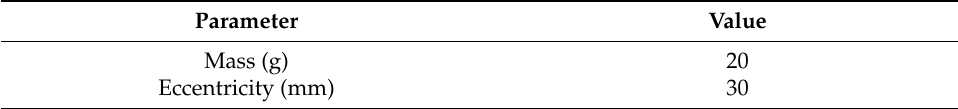
Table 2. Parameters of the internal resonance vibration